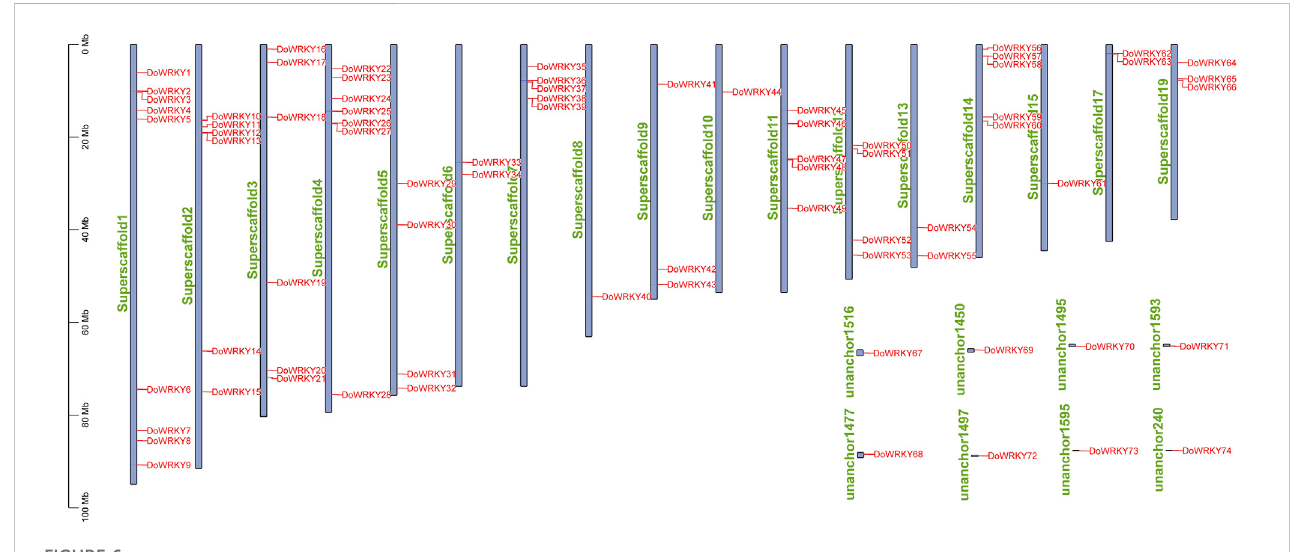
The chromosome location analysis of DoWRKY